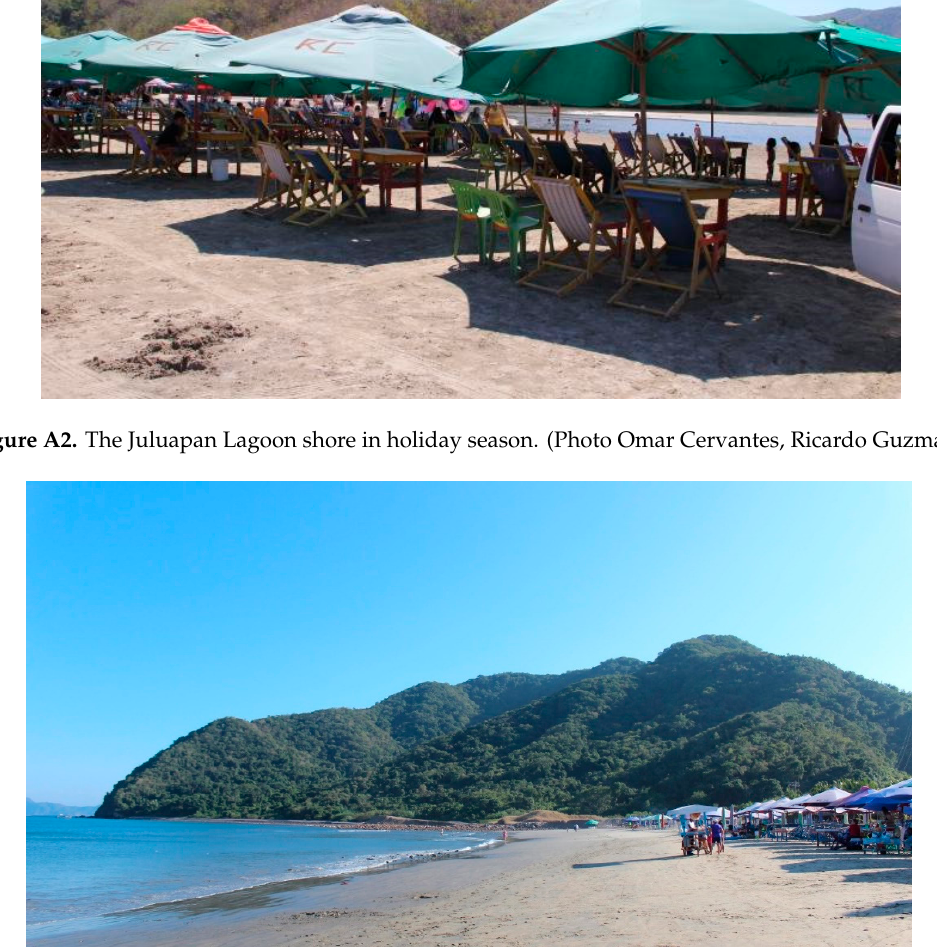
Figure A3. La Boquita Beach in low season. (Photo Penélope Membrilla González).